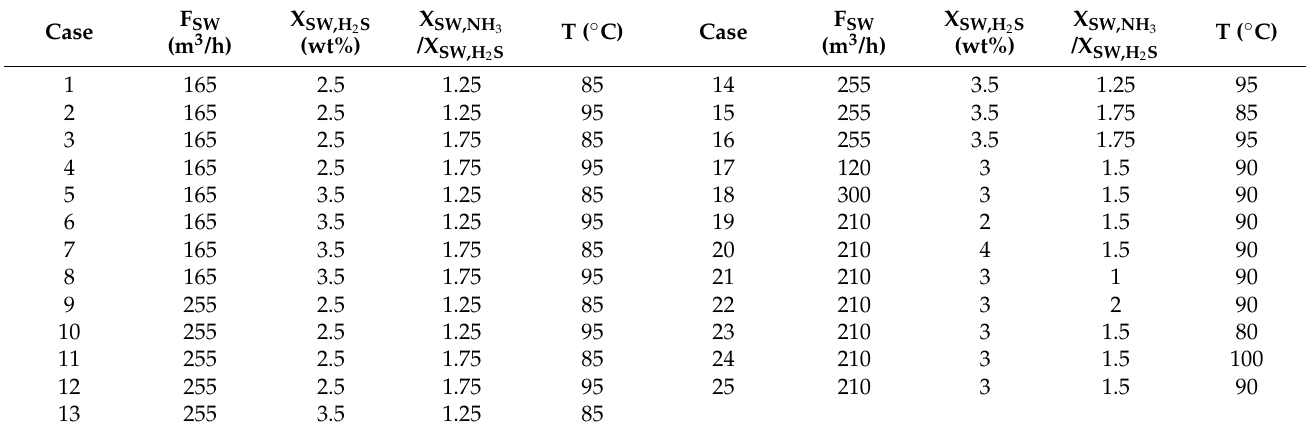
Table 1. Experimental simulation cases for the development of minimum reboiler duty predictor.